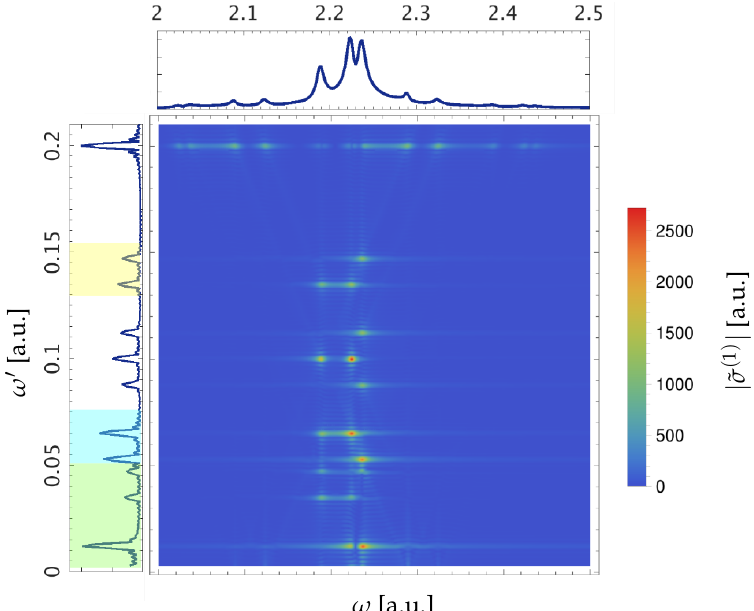
Figure 5. | ˜ σ ( 1 ) ( ω , ω (cid:48) ) | , i.e., the modulus of the Fourier transform of the XUV one-photon cross-section σ ( 1 ) ( ω , τ ) , calculated with Equation (24).